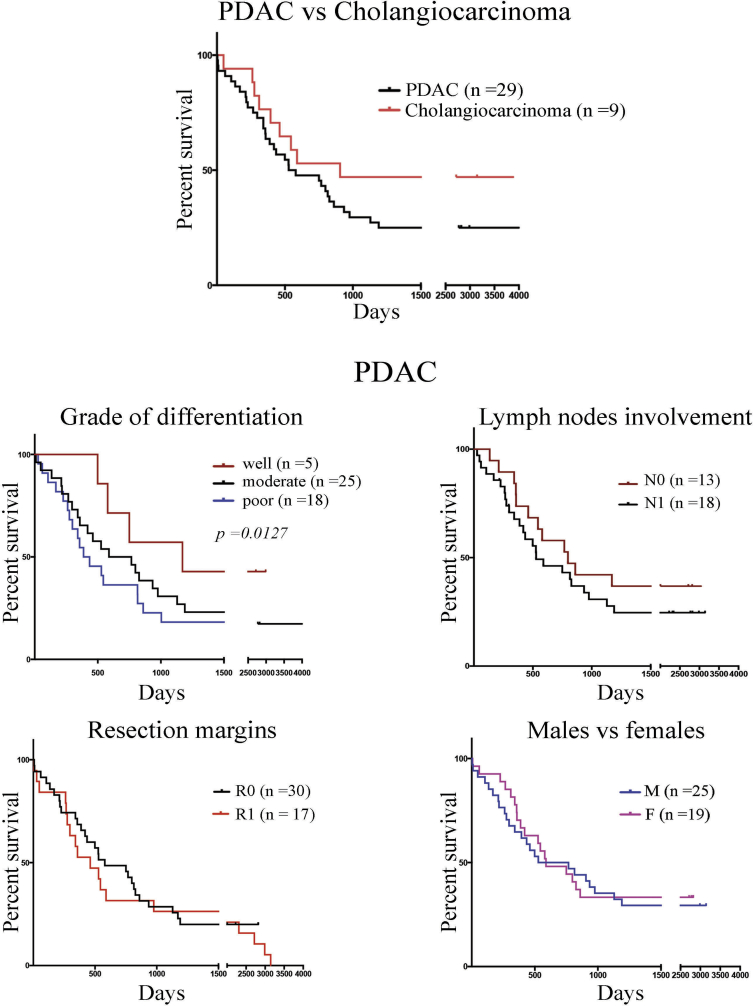
Supplementary Fig. 3Juxtatumoral and normal adjacent vascular density impact on prognosis. Kaplan-Meier curves were obtained after patients for various factors which may have prognostic impact. Comparisons were made by Log-rank (Mantel Cox) test. For each patient (number, n=), data are obtained by calculating the average MVD and TVA measured within the specific parenchymal area for that patient. A: PDAC versus cholangiocarcinoma overall survival in this patient cohort, B–E: Grade of tumour (B), lymph nodal involvement (B), resection margin involvement and impact on sex in patients with PDAC and their survival.